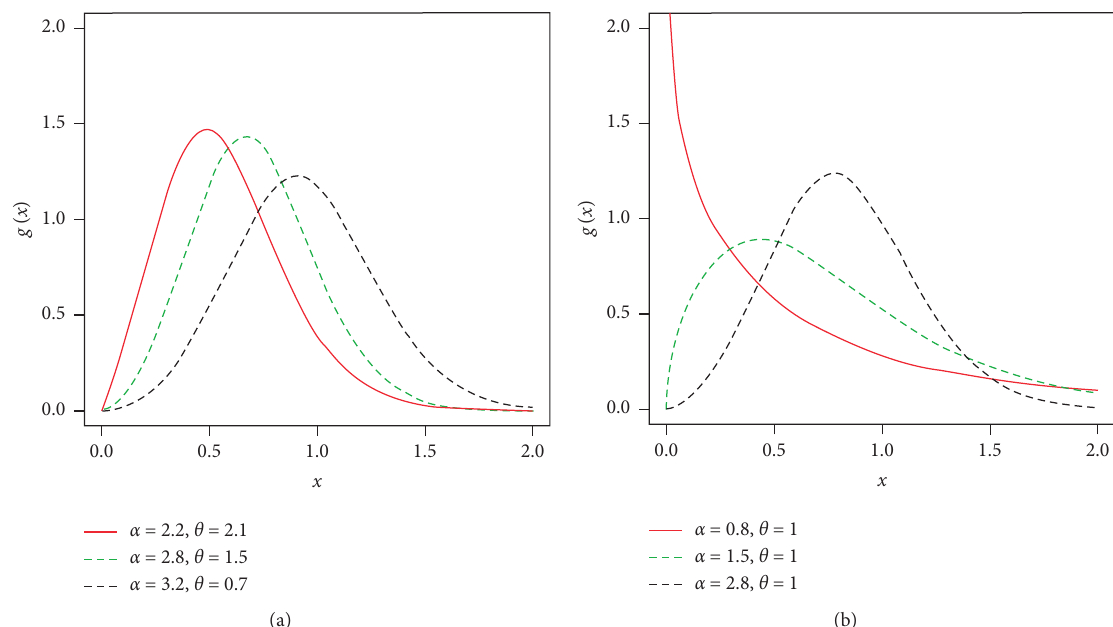
Figure 6: Different plots for the pdf of the NEP-Weibull